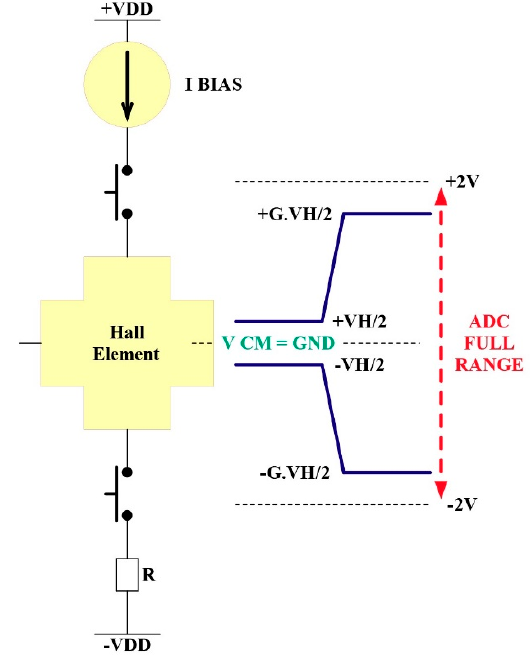
Figure 4. The differential signal levels at the Hall element output and after amplification.